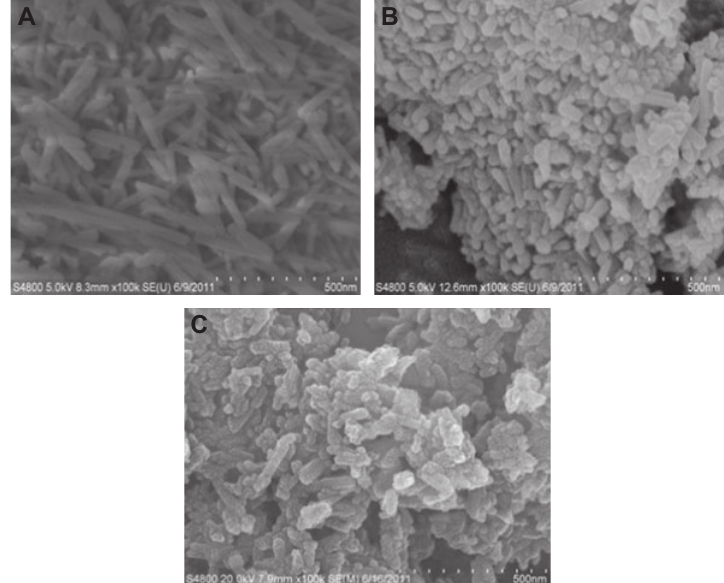
Figure 1 SEM micrographs of (A) HAP particles, (B) dodecyl alcohol treated HAP particles and (C) silica-coated